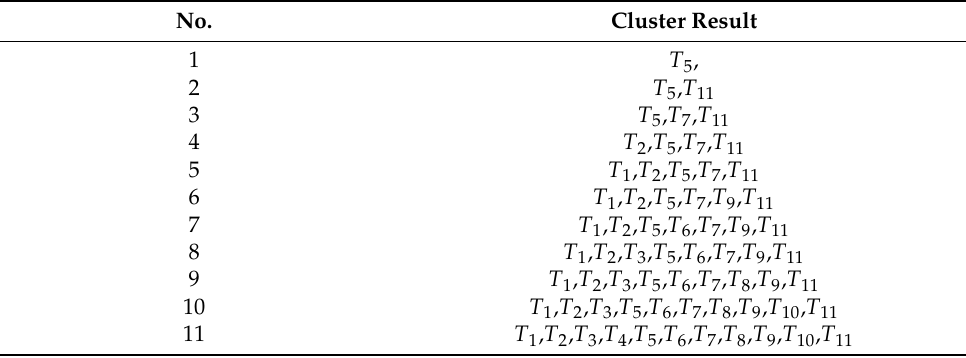
Table 5. The combination of the representative variables in each